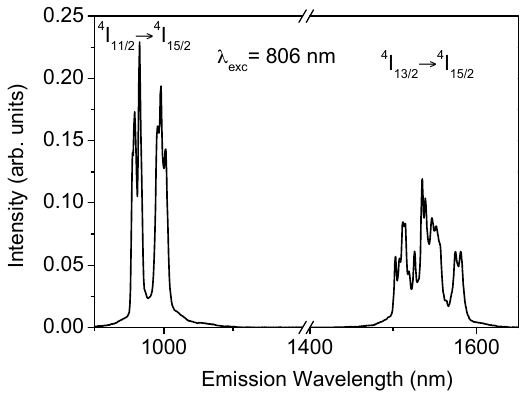
Figure 1. Room temperature emission spectrum obtained under excitation at 806 nm ( λ exc is the excitation wavelength).